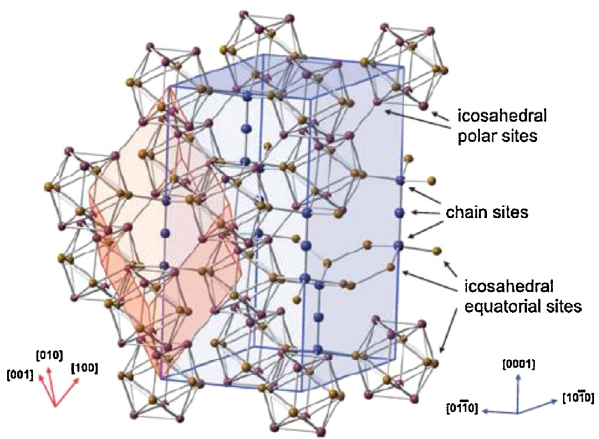
Fig. 1. Cell structure of boron carbide B 4 C (from Ref.